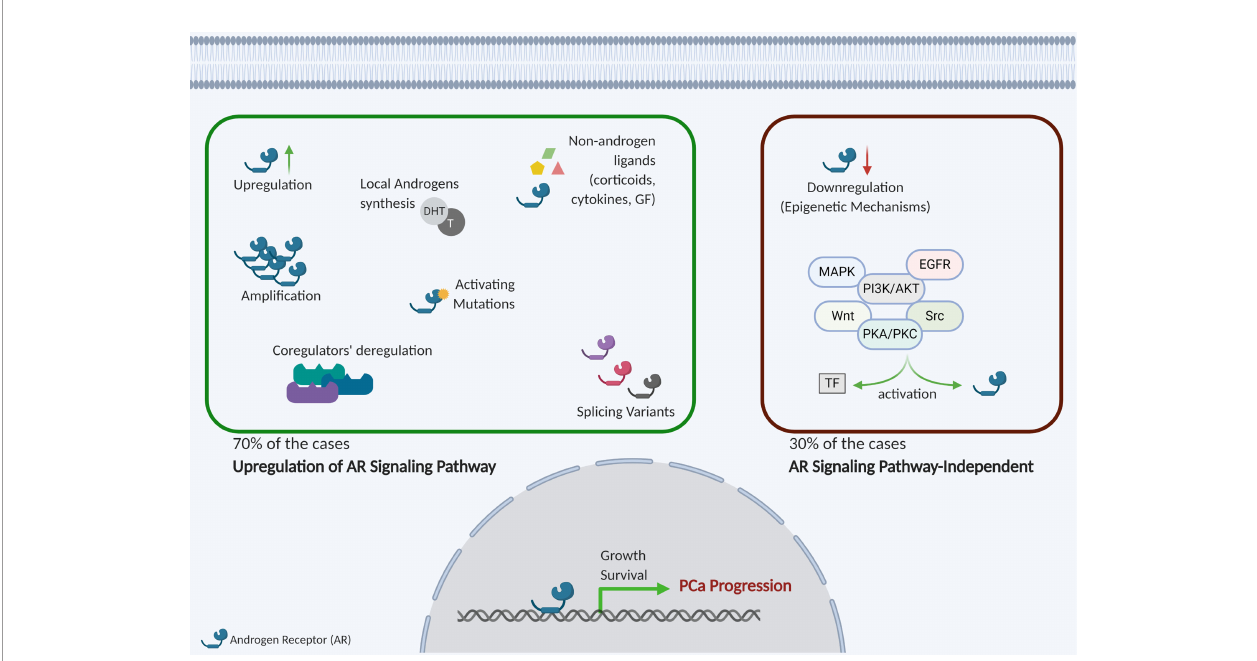
FIGURE 2 | Mechanisms of resistance to androgen deprivation therapy. The process underlying ADT resistance and CRPC development involve, in 70% of the cases, upregulation of AR signaling pathway. In this case, upregulation of AR expression, ampli fi cation or activating mutations, AR splice variants, promiscuous AR activation by non-androgen ligands and deregulation of AR coactivators and co-repressors is observed. On the other hand, in 30% of the cases there is AR expression downregulation and activation of other signaling pathways involved in cell survival and growth activation. AR, androgen receptor; T, testosterone; DHT, dihydrotestosterone; GF, growth factors: TF, transcript factors. Created with